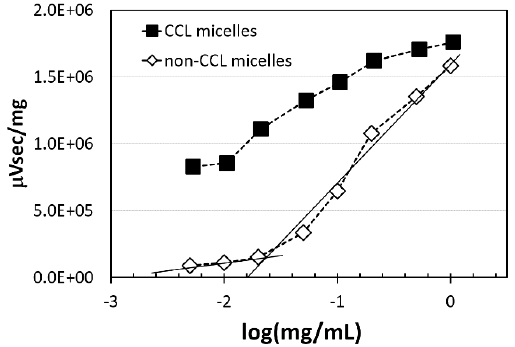
Figure 5. GPC measurements conducted before (diamond) and after (square) the photo-crosslinking of polymeric micelles. Concentrations of the polymers were in a range extending from 0.5 μ g/mL to 1.0 mg/mL. Y axis indicates normalized elution-peak areas per injected weight gram of polymeric micelles in GPC measurements. The obtained normalized elution-peak area was plotted.